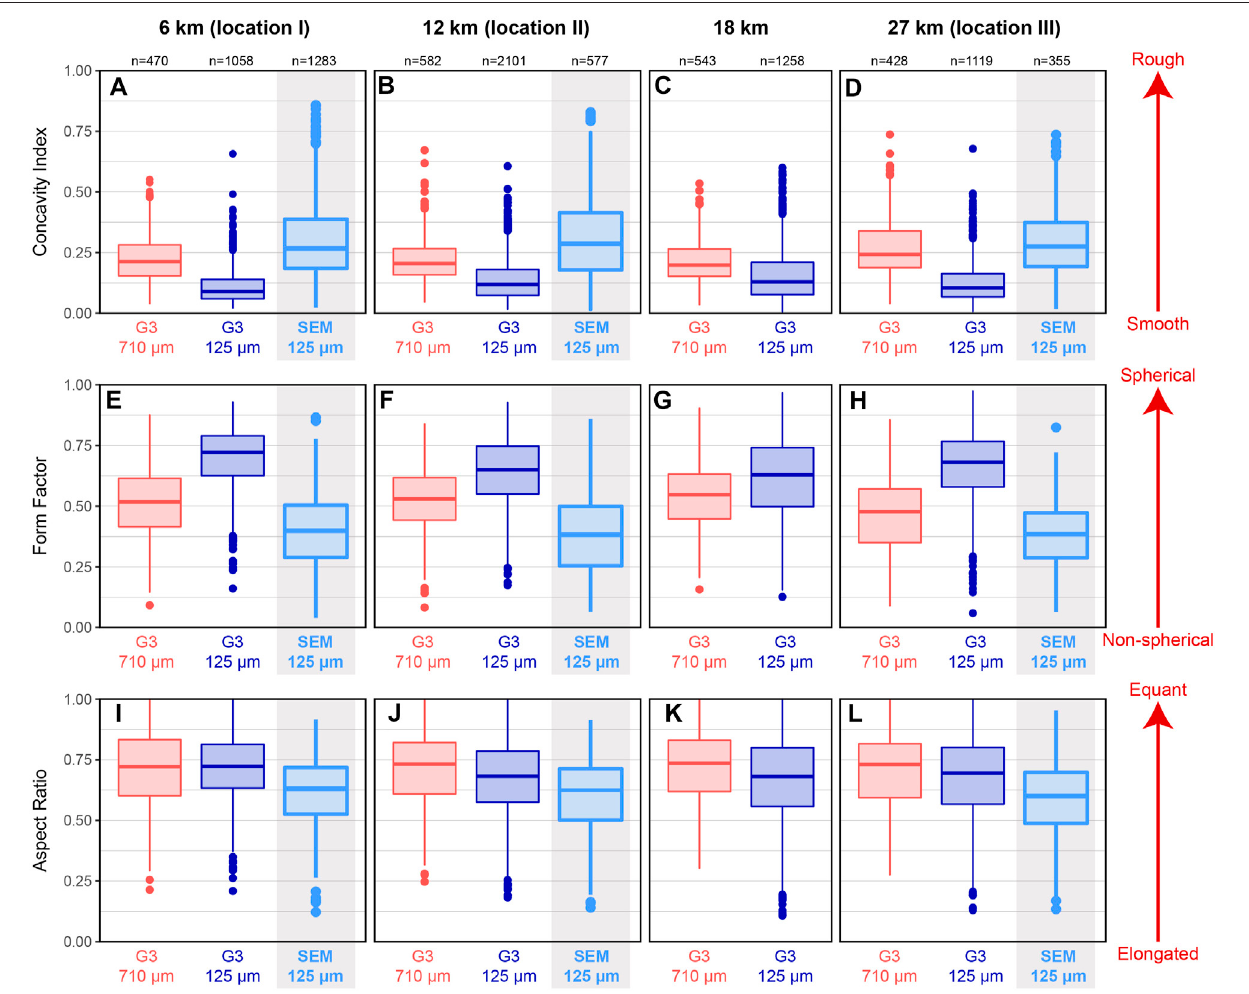
FIGURE 5 | Variations with distance from vent of the Concavity Index, Form Factor and Aspect Ratio of the bulk 710 – 1,000 μ m and 125 – 180 µm fractions represented by Tukey whiskers plots (where the thick middle line is the median, the lower and upper hinges are the 25th and 75th percentiles, the lower and upper whiskers extend from the hinge to the smallest or largest value no further than 1.5 x the inter quartile range, i.e. distance between the fi rst and third quartiles, outliers are plottedindividually).TheConcavityIndex(afterLiuetal.(2015a))isameasureoftheroughnessoftheparticles,whiletheAspectRatioisameasureoftheformofthe grains. The Form Factor is a mixed descriptor of roughness and form, and sometimes referred to as Sphericity.